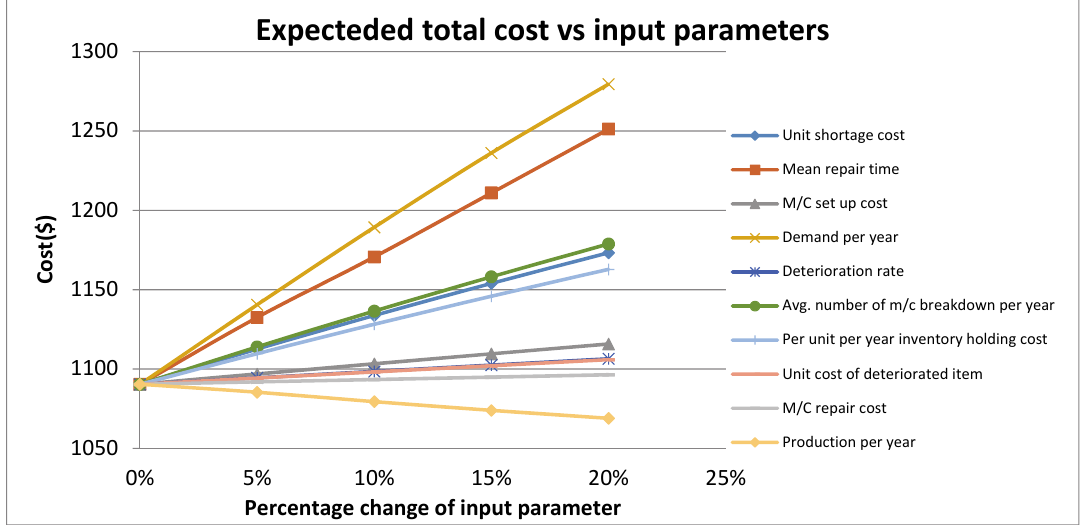
Fig. 16. Sensitivity analysis for expected total cost per unit